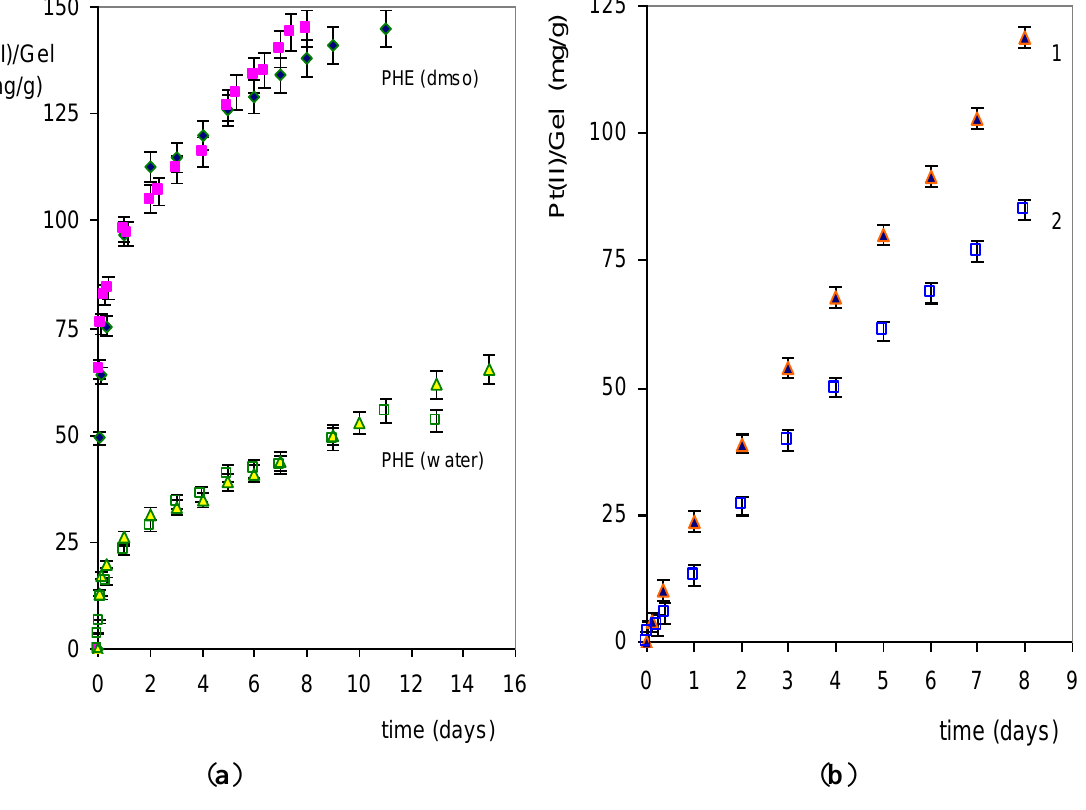
Figure 10. ( a , left): Release pattern of Pt(II)-species (Pt/gel, mg/g) from the carboxyl acid hydrogel PHE-9 [loaded with cisplatin in water and in water/DMSO solutions], into PBS buffer (pH 7.40, 25 °C); ( b , right): release pattern of Pt(II)-species from the hydrogel AVa-1 (1: red triangles) and AVa-2 (2: blue squares) in PBS buffer pH 7.40 at 25